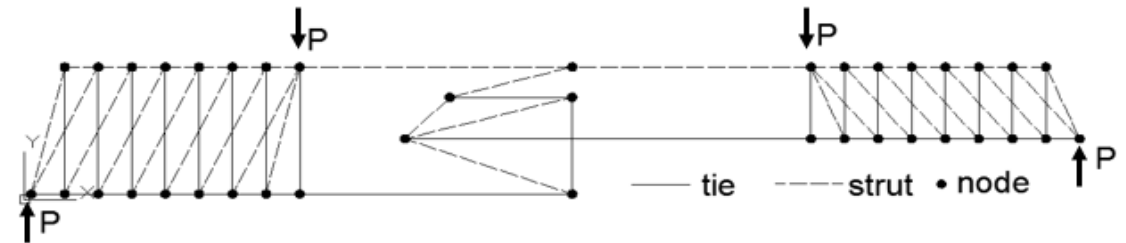
Figure 21. The proposed STM of B1.